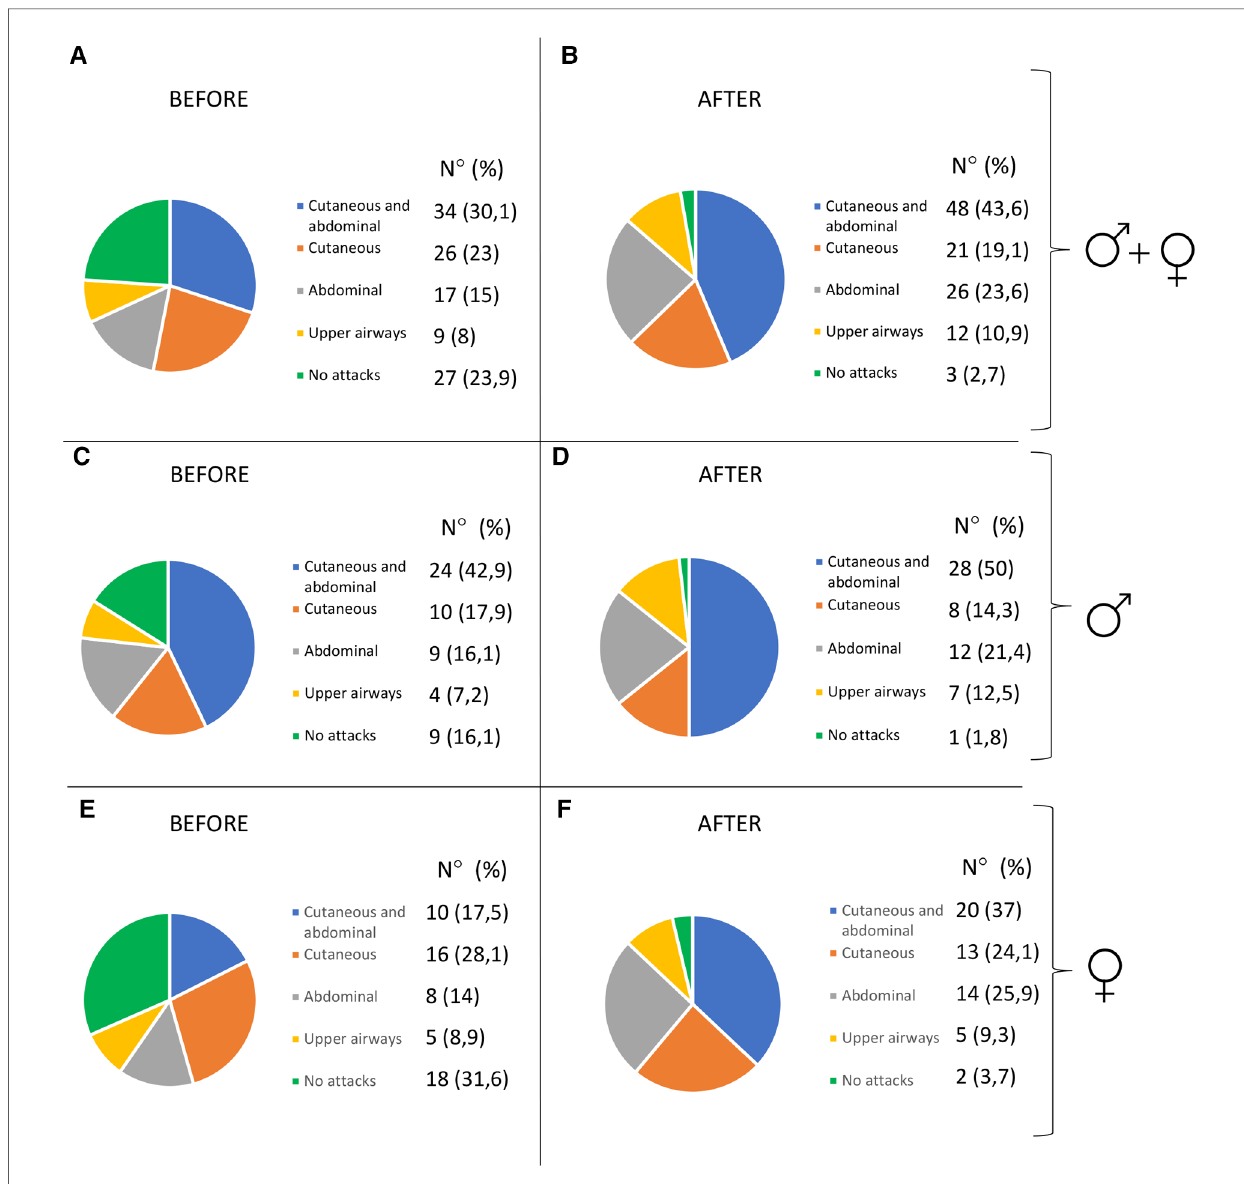
FIGURE 2 Pattern of attacks before and after puberty in all the patients ( A,B ), in males ( C,D ), and in females ( E,F